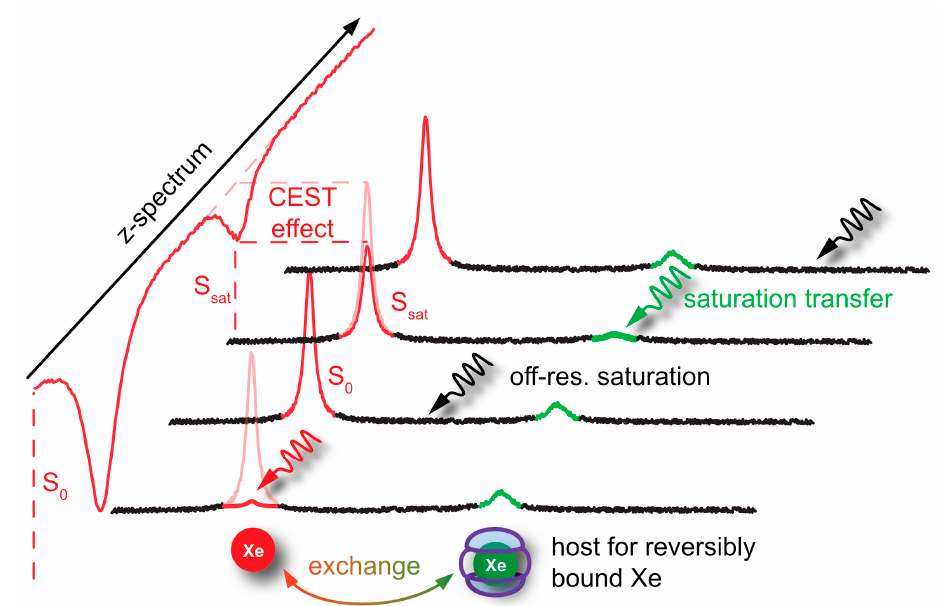
Figure 3. Principle of CEST detection. The signal of unbound Xe can be detected at high signal-to-noise-ratio while the nuclei are in constant exchange in and out of the binding site of the host. Direct saturation yields a complete signal loss while saturating onto the reversibly bound Xe yields a partial signal loss for the respective frequency offset. Sweeping the saturation frequency over a larger frequency range in a pseudo-2D experiment yields a z-spectrum with the complete shape of the CEST